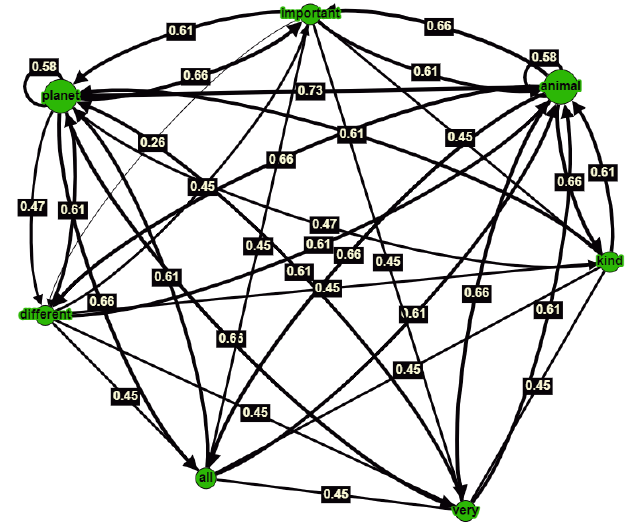
Figure 2. Semantic graph obtained after processing a short sample text using the ICAN algorithm.